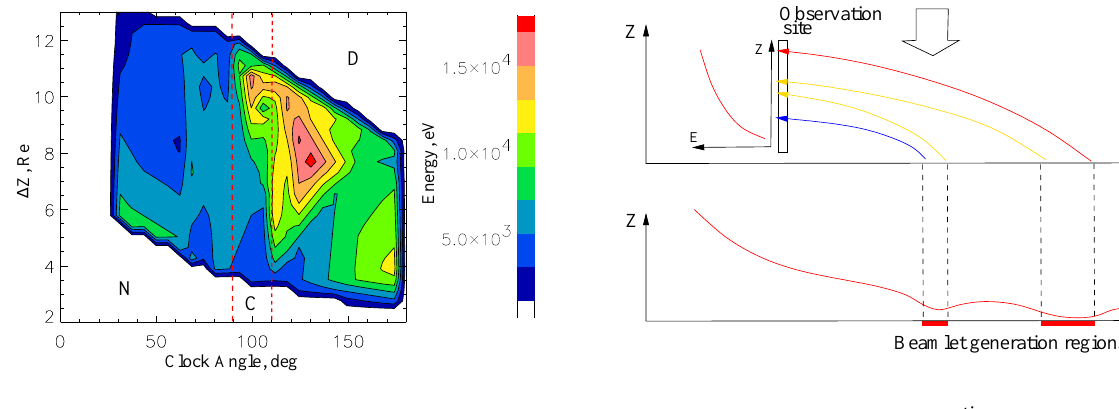
Fig. 12. Color-coded beamlet energy histogram displayed in the IMF clock-angle – 1Z plane. Two vertical lines divide the clock- angle range into three zones: D - disturbed conditions in the magne- tosphere, C - quiet conditions, and N - the northward IMF direction.